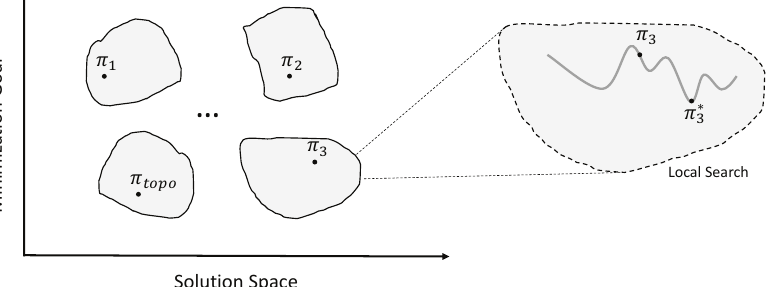
Figure 3. Feasible regions indicated by different task priority queues.